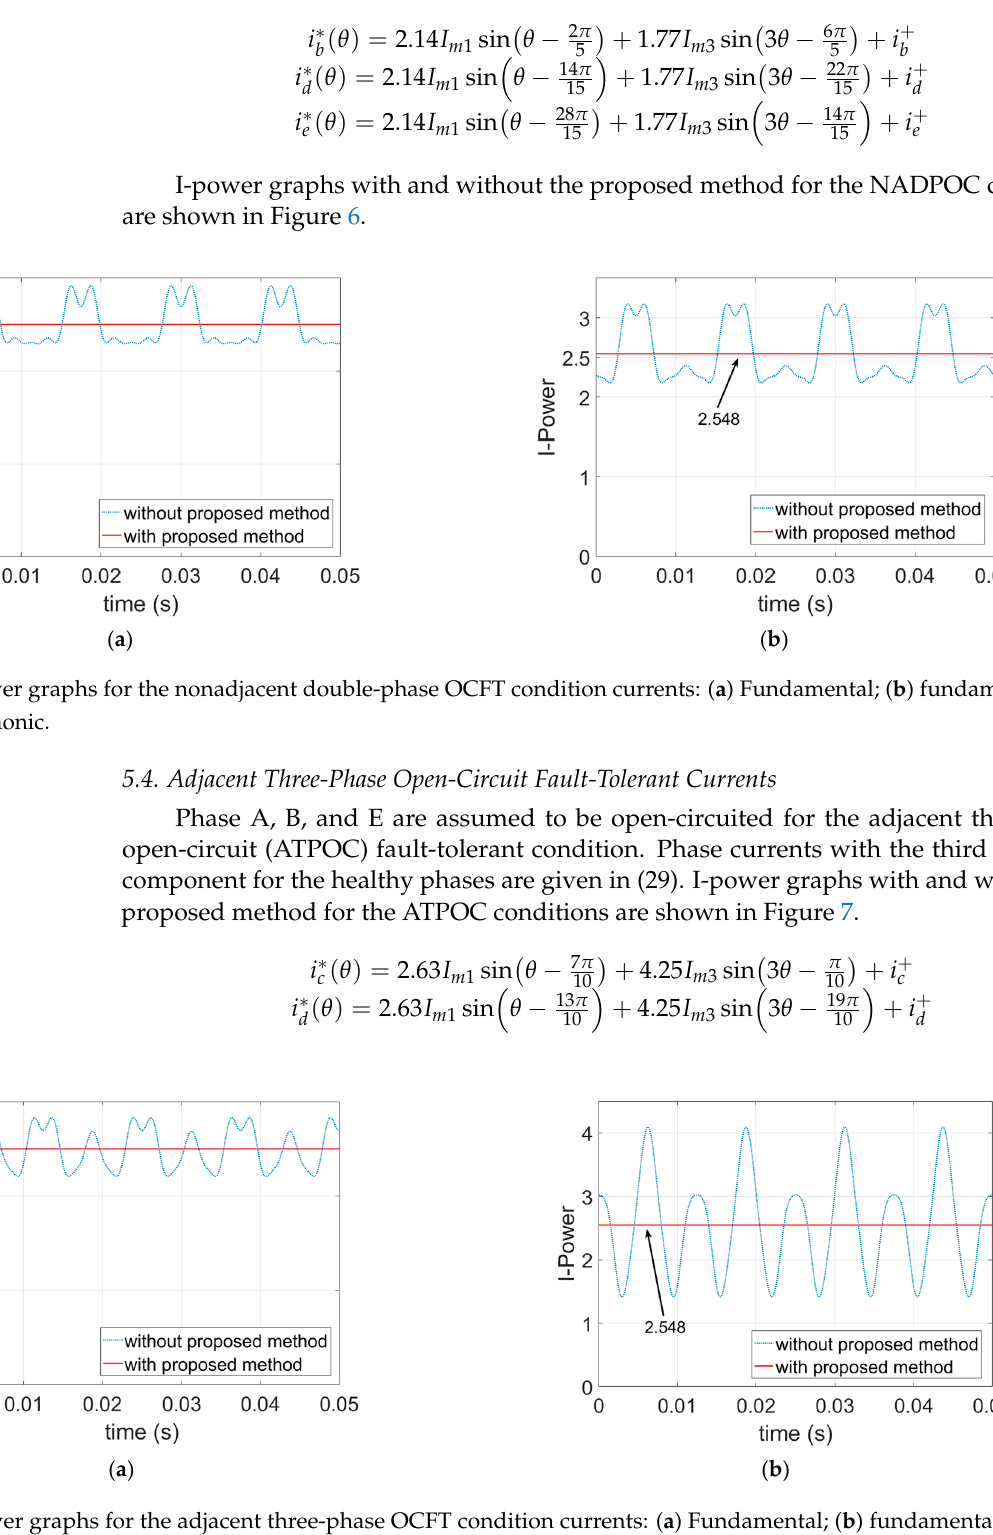
( b ) Figure 8. I-power graphs for the nonadjacent three-phase OCFT condition currents: ( a ) Fundamental; ( b ) fundamental plus third harmonic.